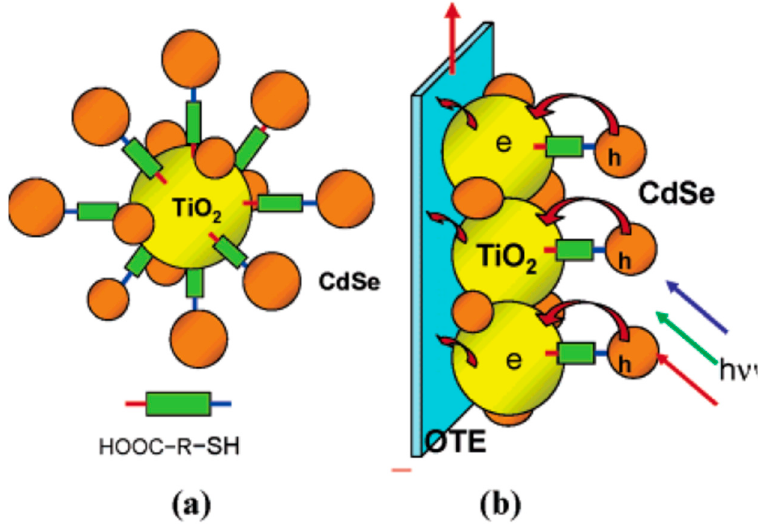
Figure 4. ( a ) The absorption of single CdSe QDs onto the metal oxide membrane supported by binding agents and ( b ) photoanode is formed by coating system ( a ) with the FTO glass substrate [84].